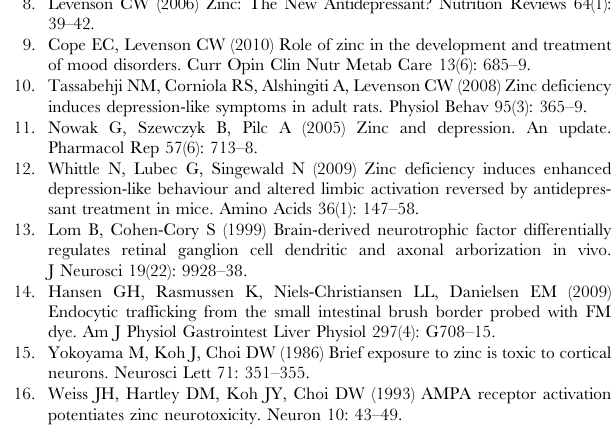
Figure S2 A) Overview of images of HEK293 (upper panel) and neurons (lower panel) shown in detail in Figure 2B. White squares indicate regions shown in Figure 2B. Bottom row of images in each